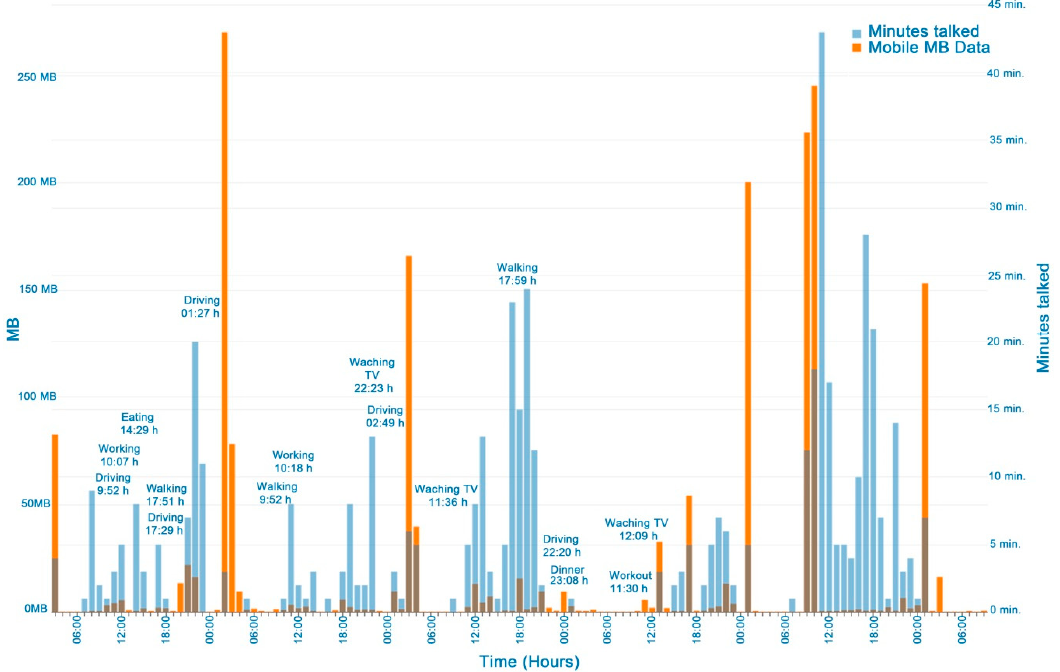
Figure 7. Data traffic (Mb) and time of talking or listening to sounds (minutes) by HDRS monitoring.